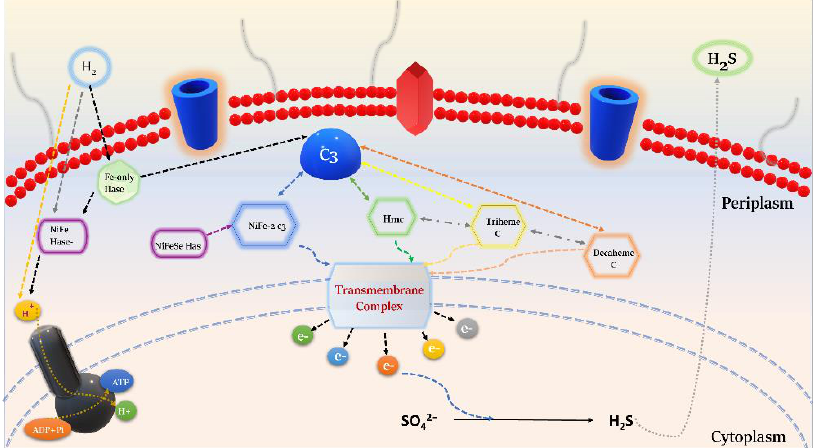
Figure 5. Diagrammatic description of a possible electron transport mechanism in D. vulgaris Hildenborough throughc-type cytochrome network and the associated periplasmic hydrogenases. The hydrogen oxidation generates electrons that are transferred into the c-type cytochrome via membrane-bound electron carriers, facilitating the reduction of sulfate to hydrogen sulfide.